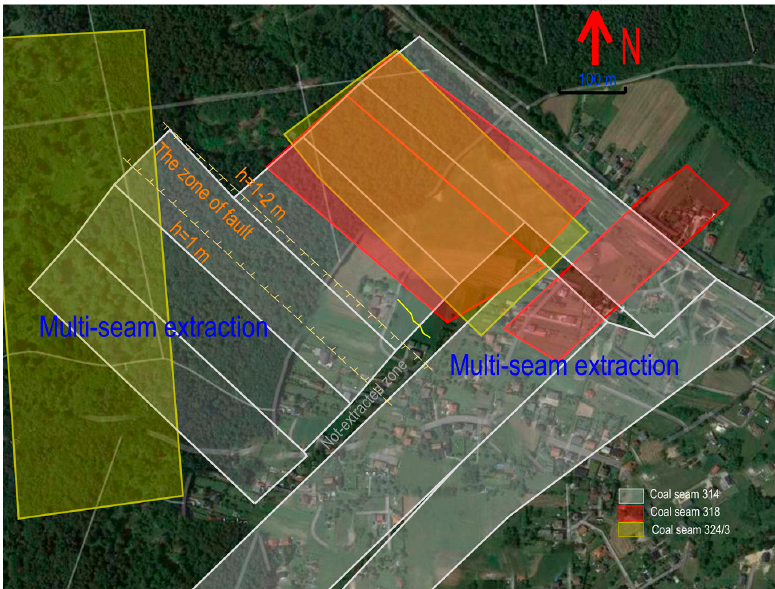
Figure 4. Sketch of multi-seam extraction edges in the vicinity of the discontinuous